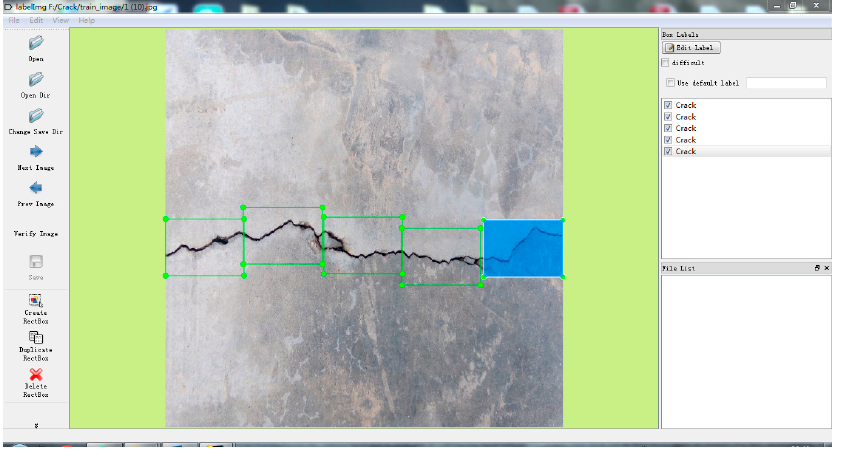
Figure 2. Crack image mark.